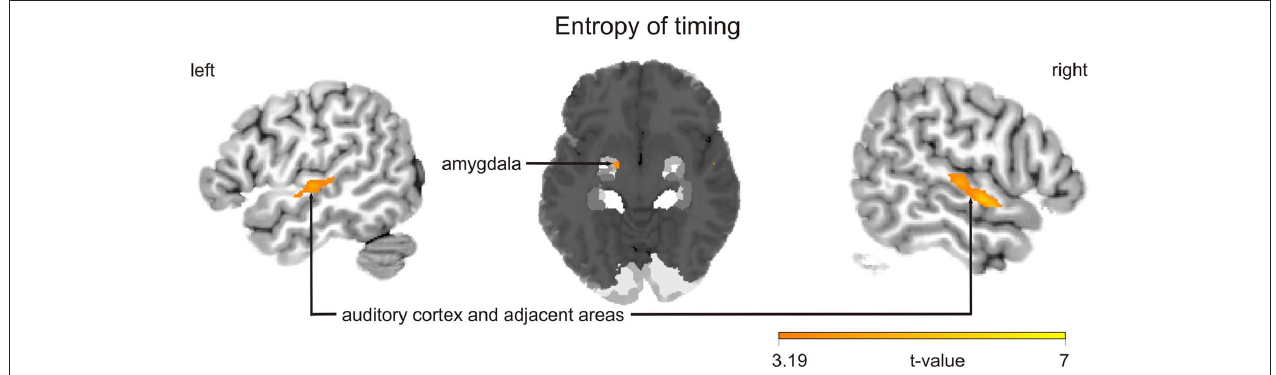
FIguRe 4 | Blood oxygen level dependent activation patterns for the contrast for the parametric analysis, in which each melody, regardless of its true status as improvised or imitated, was weighted with its entropy of timing (inter-onset intervals). Clusters show that brain activation is positively correlated with this performance parameter. Similar results were observed for